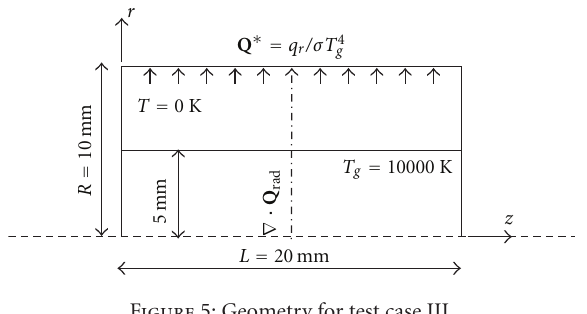
Figure 5: Geometry for test case III.